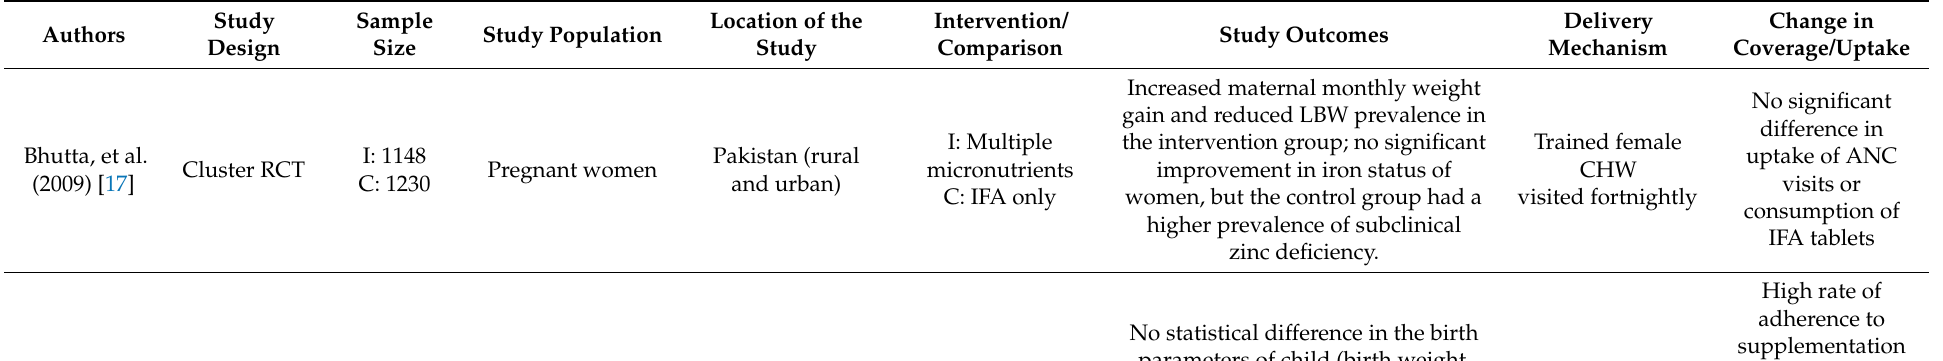
Table 1. Characteristics of the included studies ( n =